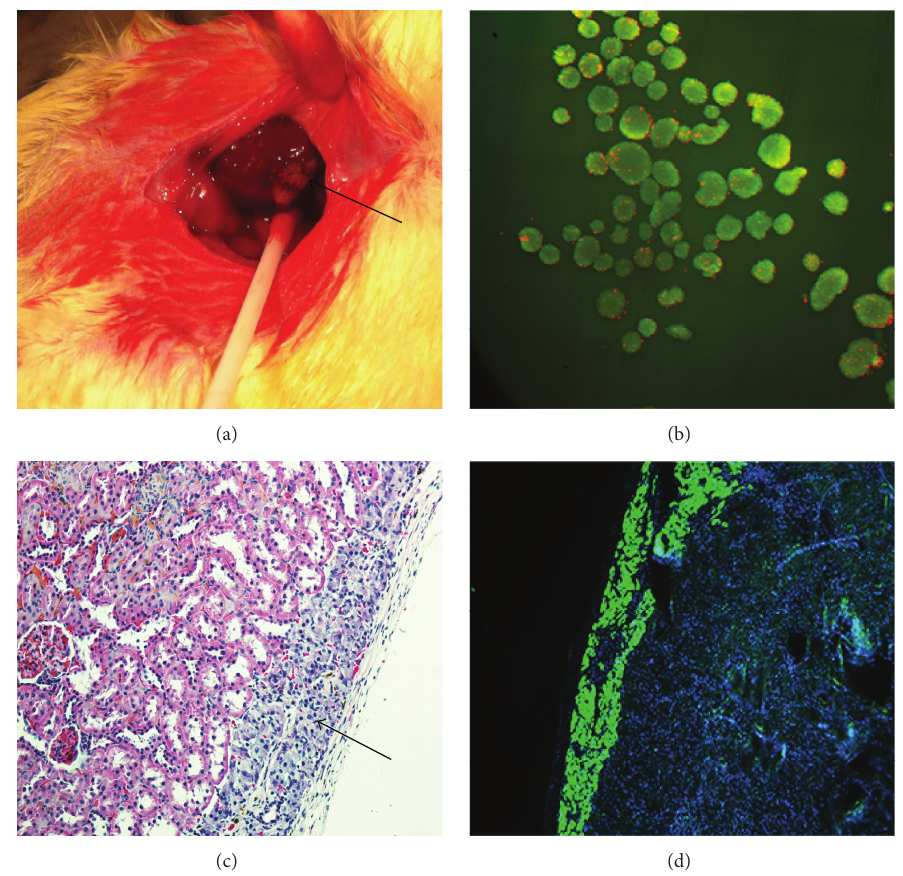
Figure 2: Islet transplantation under the kidney capsule and evaluation of islet activity. (a) Islets transplanted into the renal subcapsular space. (b) Activity evaluation of isolated islets (FDA-PI staining, × 100). (c) Transplanted islets under the kidney capsule (HE staining, × 200). (d) Insulin immunofluorescence staining (green, ×